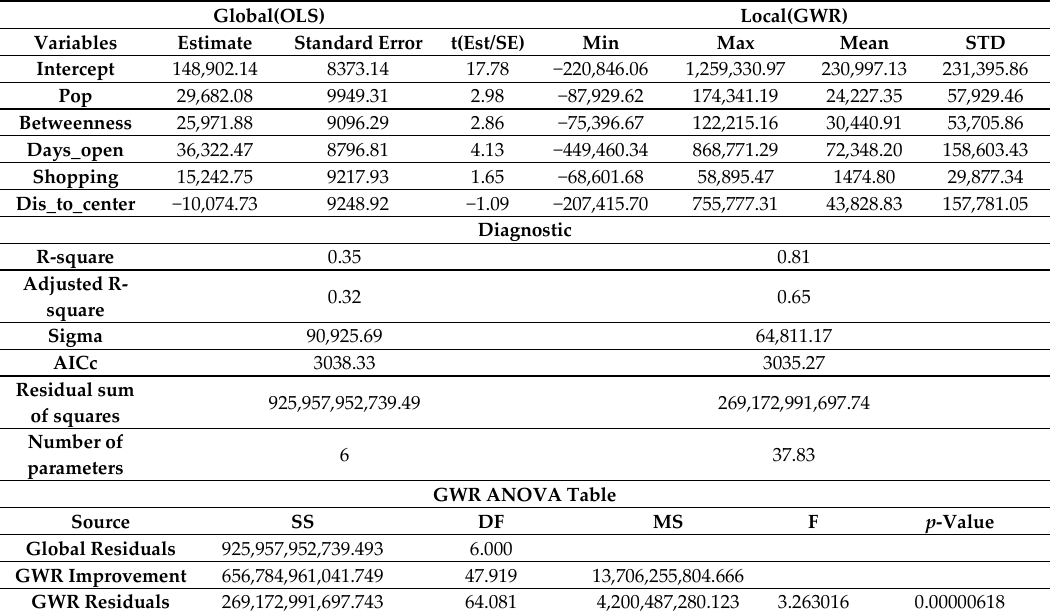
Table A1. Results of the model for Weekly_ridership.